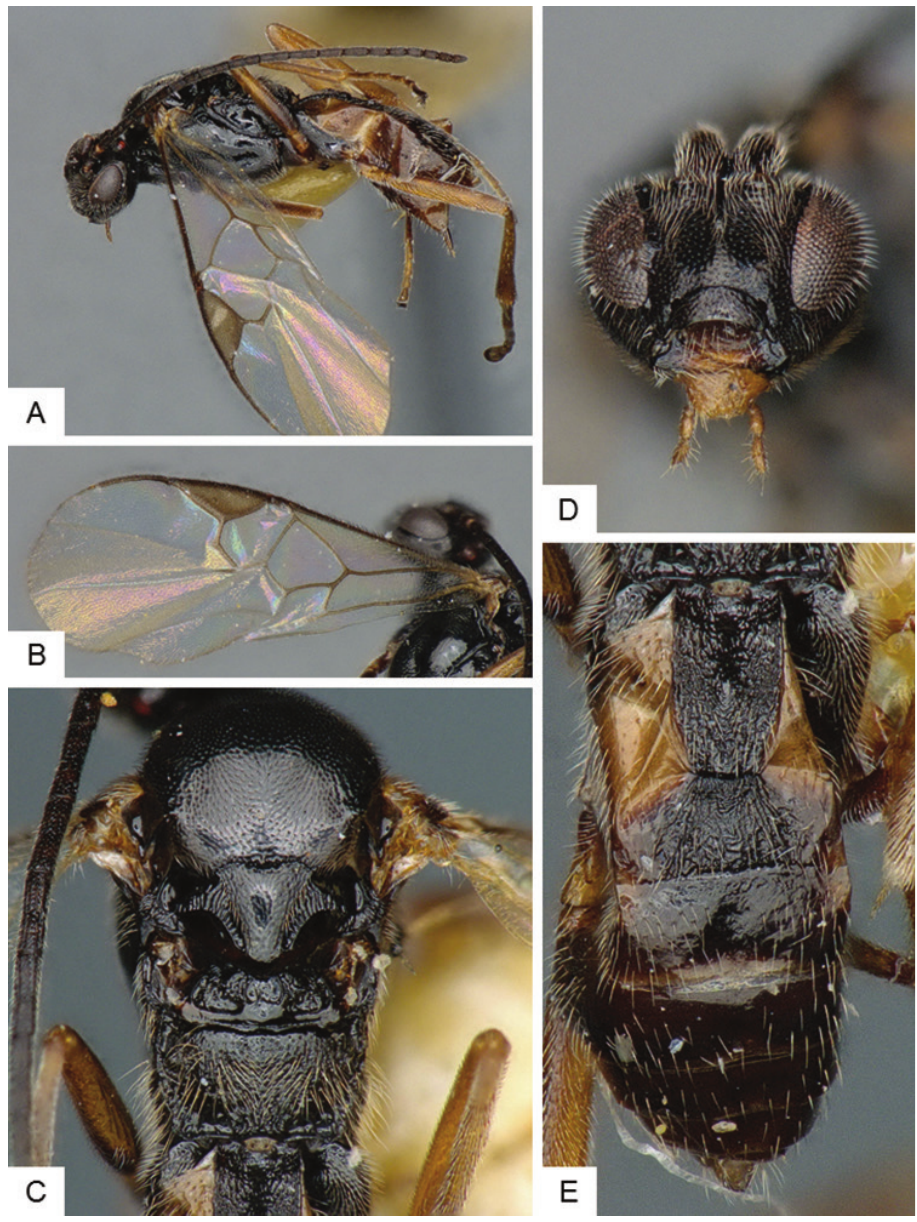
Figure 14. Glyptapanteles sp. 1. A Habitus, lateral B Fore wing C Mesosoma, dorsal D Head, frontal E Metasoma,